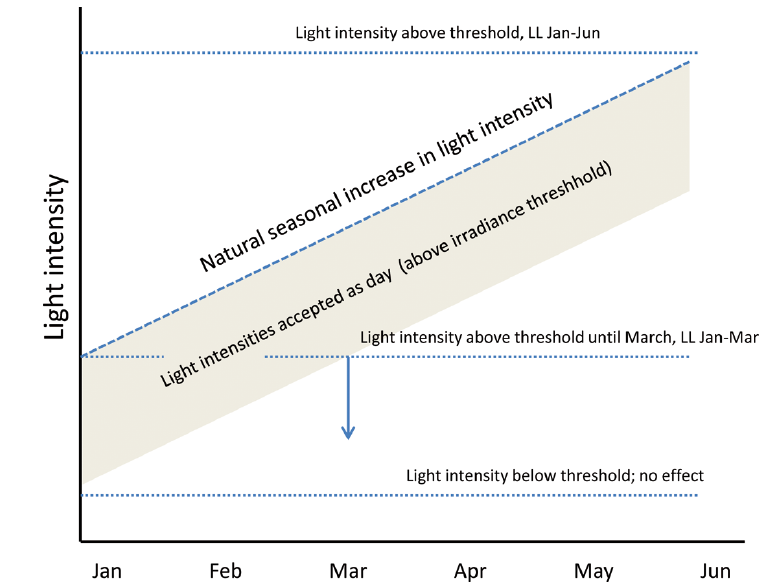
Fig. 8. Possible model for how artificial light of different intensities can translate into a periodic continuous light effect. Natural light increases in period and irradiance during late winter and spring. If the irradiance from the artificial light source is high enough, it will give a long day signal throughout late winter and spring, while irradiances that remain below the threshold will not be experienced as different from the natural light. A light source at intermediate irradiation will give a long day signal until it is outcompeted by the natural light. LL: continuous artificial